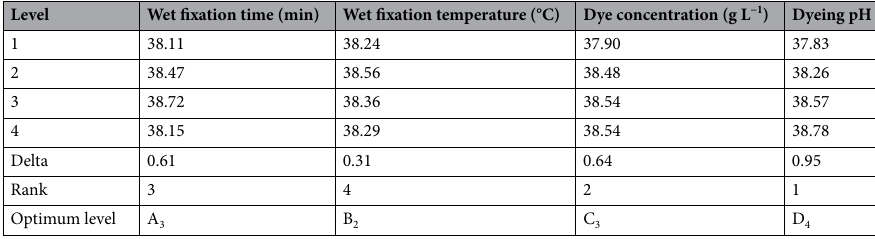
Table 4. Response table data with S/N ratio of dye fixation